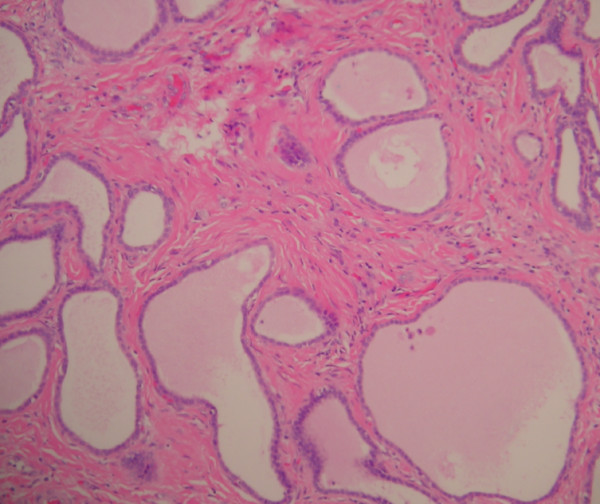
Ducts of Luschka.